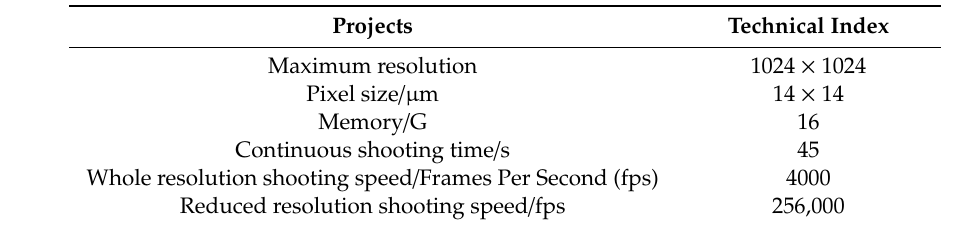
Table 2. Specific parameters of the camera.